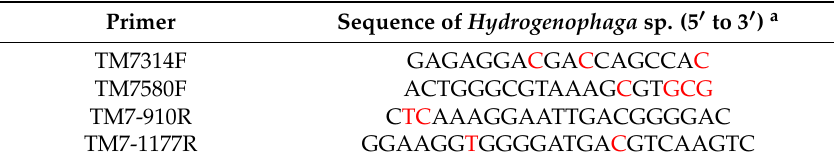
Table 4. Sequence mismatches of the primers and the targeted 16S rRNA gene region of Hydrogenophaga sp. Primer Sequence of Hydrogenophaga sp. (5 (cid:48) to 3 (cid:48) ) a TM7314F GAGAGGACGACCAGCCAC